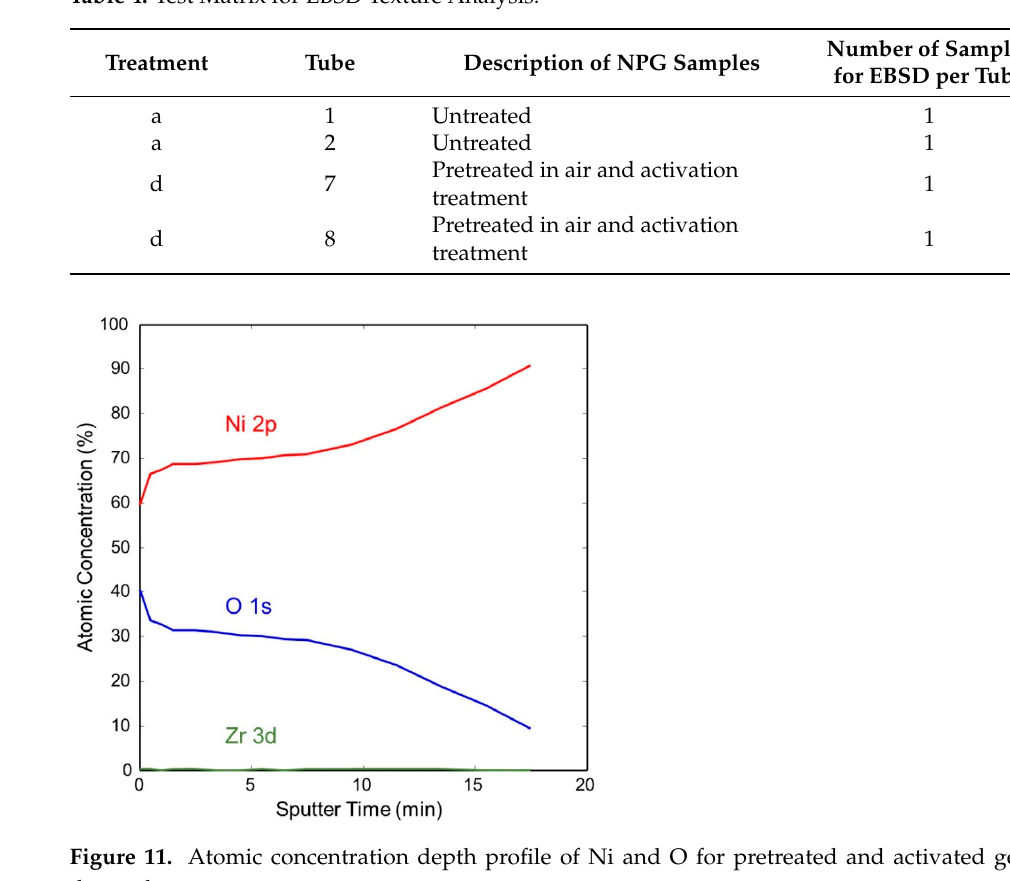
Table 4. Test Matrix for EBSD Texture Analysis.